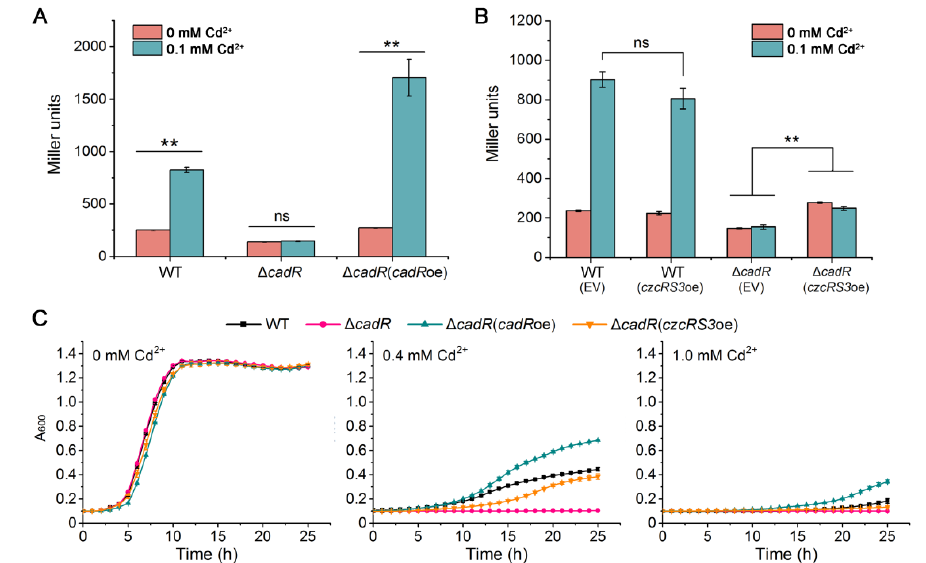
Figure 5. Involvement of CadR in czcRS3 expression. ( A ) The expression level of czcRS3 in wild-type KT2440 (WT), deletion Δ cadR , and overexpressed Δ cadR ( cadR oe) which harbors pB403- cadR . ( B ) The expression level of czcRS3 in KT2440 strains with overexpressed czcRS3 . The activity of β -galactosidase expressed from pBRTZ- czcR3 was measured after treatment with or without CdCl 2 for 4 h. ( C ) The growth of Δ cadR with overexpressed cadR ( cadR oe) or czcRS3 ( czcRS3 oe) in LB medium supplemented with CdCl 2 at the indicated concentrations. The data represent the mean ± standard deviation of three replicates. The significant difference was determined by Student’s t -test (** p < 0.01; ns, non-significant, p >